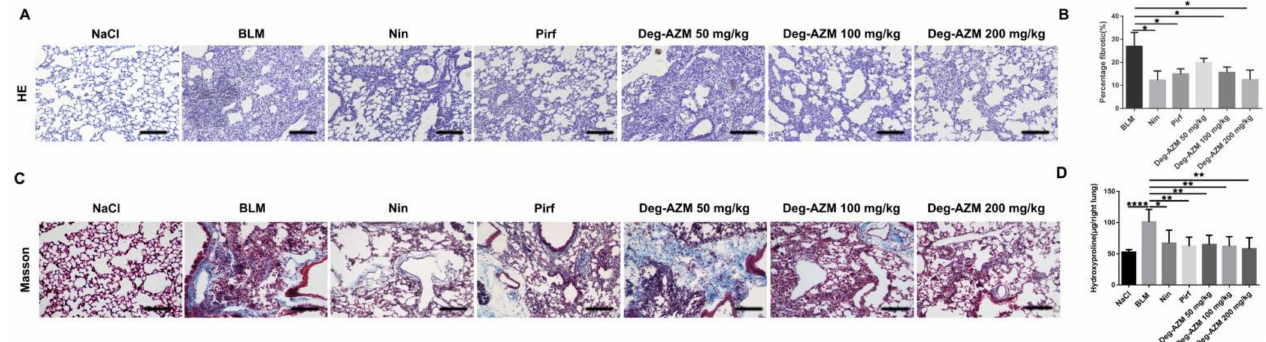
Figure 2. Deglycosylated azithromycin attenuates bleomycin-induced pulmonary fibrosis in mice. ( A ) Lung tissue sections were stained with hematoxylin-eosin (HE). ( B ) Statistics of lung fibrosis area among groups. ( C ) Lung tissue sections were stained with Masson Trichrome staining. ( D ) Hydroxyproline (HYP) contents of lung tissues in mice. Scale bar = 50 µ m. Data are presented as the means ± SD ( n = 8). Comparisons between groups were achieved using one-way analysis of variance (ANOVA). * p < 0.05, ** p < 0.01, *** p < 0.001, **** p <